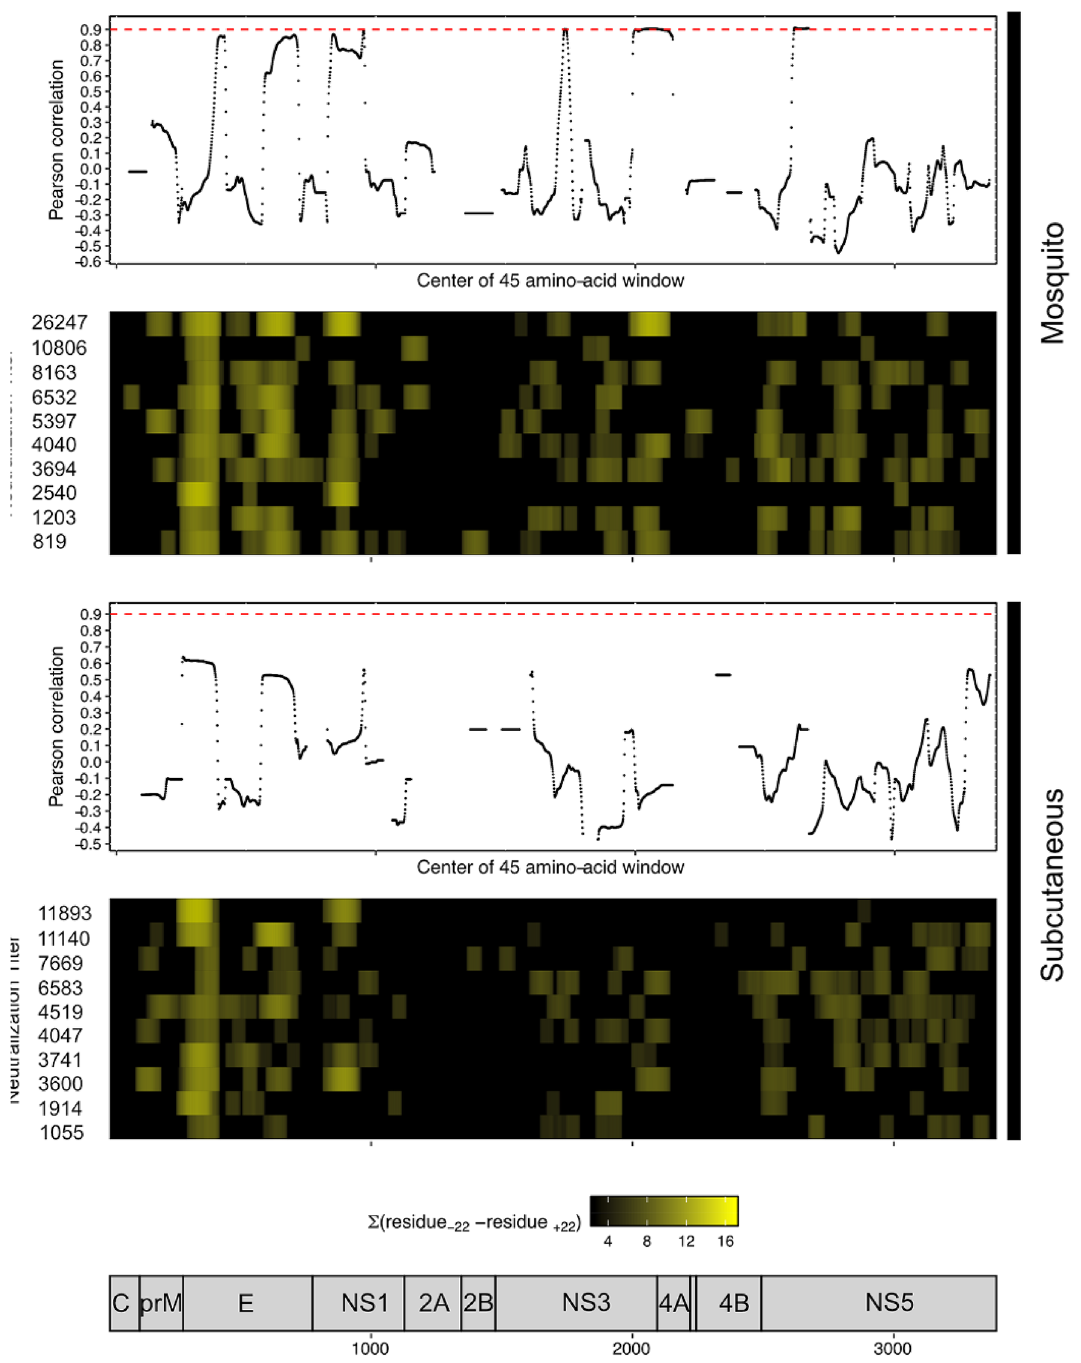
Figure 4. Phage display enrichments in NS3 and NS5 proteins correlate with late neutralization titers. Enrichment data from PhIP-Seq experiments 365 days post-infection was correlated with 13 month neutralization titers, by calculating the summation of enrichments for all 45 amino-acid windows across the DENV1 proteome (shown in heat maps). No 45-amino-acid windows in the E protein achieved a Pearson correlation of greater than 0.9 in either group (red dashed line). However, in the mosquito-infected group several windows in the NS3 and NS5 proteins did have Pearson correlation coefficients of ≥ 0.9. Neutralization titers from each animal (geometric mean titer) are shown on the